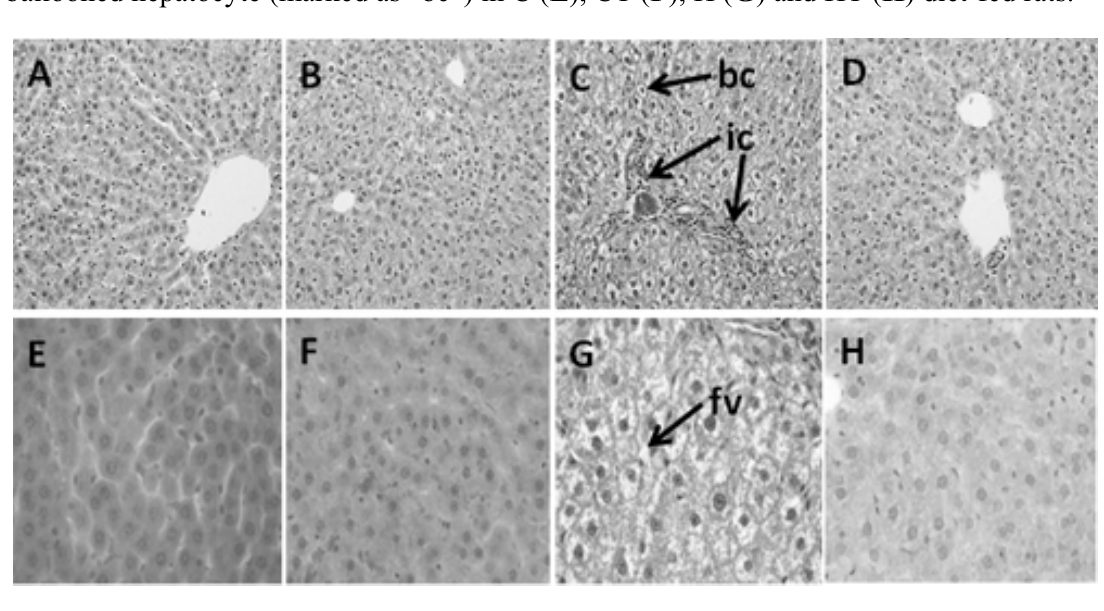
Figure 5. Haematoxylin and eosin staining of hepatocytes showing inflammatory cells around the portal region (marked as “ic”) (20×) in C ( A ), CT ( B ), H ( C ), and HT ( D ) diet-fed rats and hepatocytes with enlarged fat vacuole (marked as “fv”) (40×) and ballooned hepatocyte (marked as “bc”) in C ( E ), CT ( F ), H ( G ) and HT ( H ) diet-fed